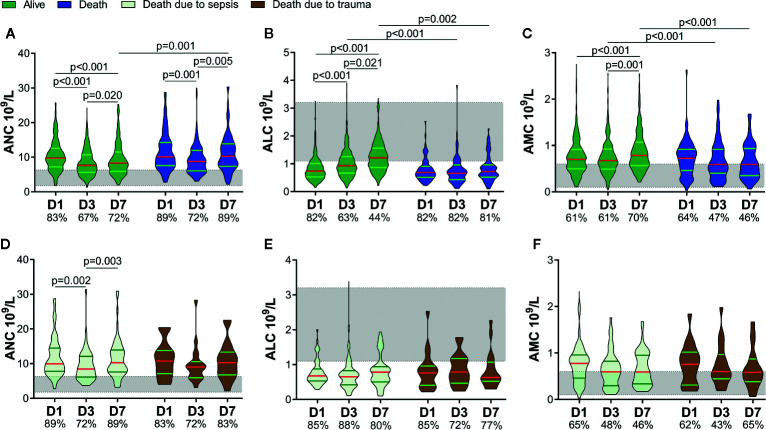
Circulating immune-cell counts of living and dead patients. Circulating immune-cell counts showed worse early alterations in non-survivors. They did not differ between non-survivors who died of sepsis and those who died of trauma. The proportions of patients with an absolute neutrophil count (ANC) and absolute monocyte count (AMC) above the upper limit of the normal range (shaded area) are shown on the x-axis (A, C, D, F). The proportions of patients with an absolute lymphocyte count (ALC) below the lower limit of the normal range (shaded area) are shown on the x-axis (B, E). D1, day-1; D3, day-3; D7, day-7.